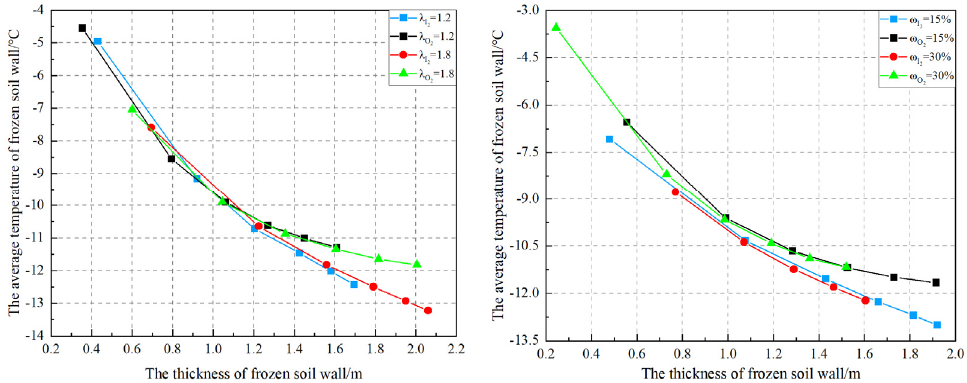
Figure 23. The relationship between thickness and the average temperature of the frozen soil wall under freezing time within 180 d.